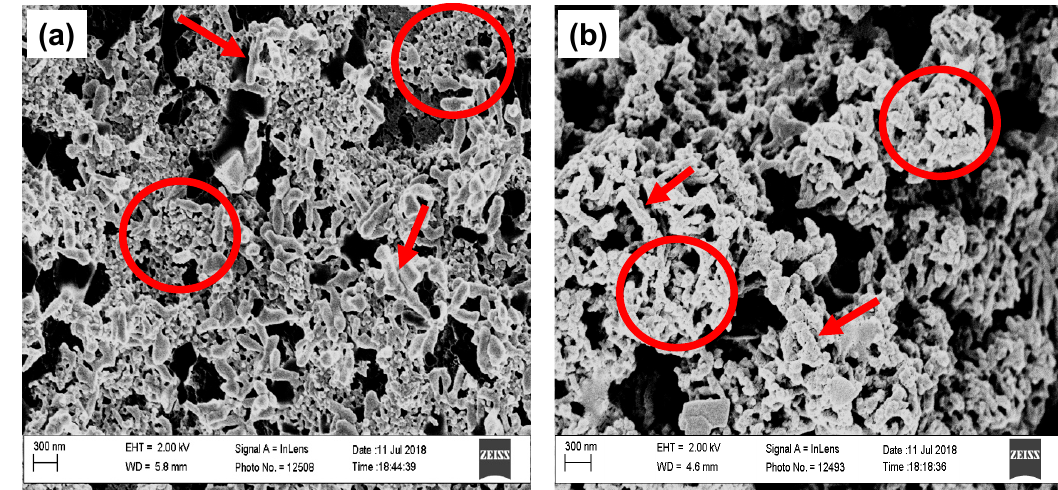
Figure 4. SEM micrographs showing the working electrode surface morphology of SPE modified by ( a ) PANI and ( b ) PANI-PAC. Arrows and circles are sections where morphological changes are visible upon the adsorption of PAC onto PANI, depicting the formation of PAC-PANI nanocomposites, as suggested by the coating-like appearance on the surface of nanofiber-like structures, and the reduction due to high-density coating in sections showing smaller nanoparticle-like structures, respectively.